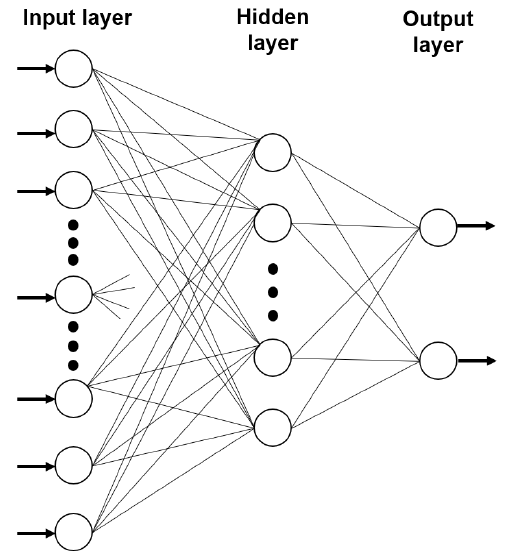
Figure 4. Feedforward neural network structure.